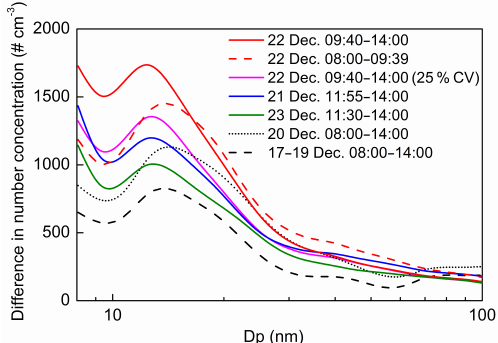
Figure 7. The size-dependent difference in particle number con- centrations between the two sites in December 2011 (solid and dash lines represent the results during NPF and non-NPF periods, respec- tively).